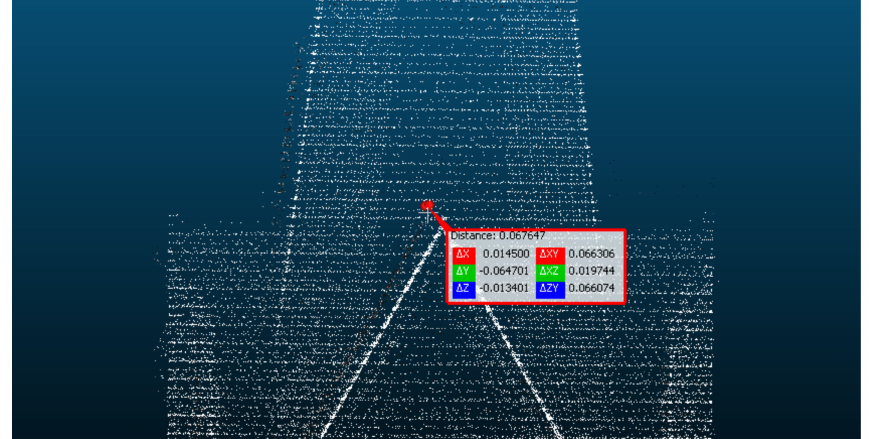
Figure 8. The distance between the thermal imaging point cloud and that obtained from the Phantom 4 PRO, on the example of the clock tower.